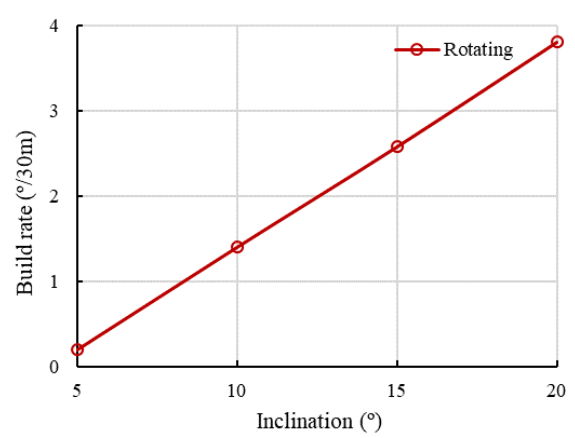
Fig. 9. The cloud map of well length with 40 different design schemes